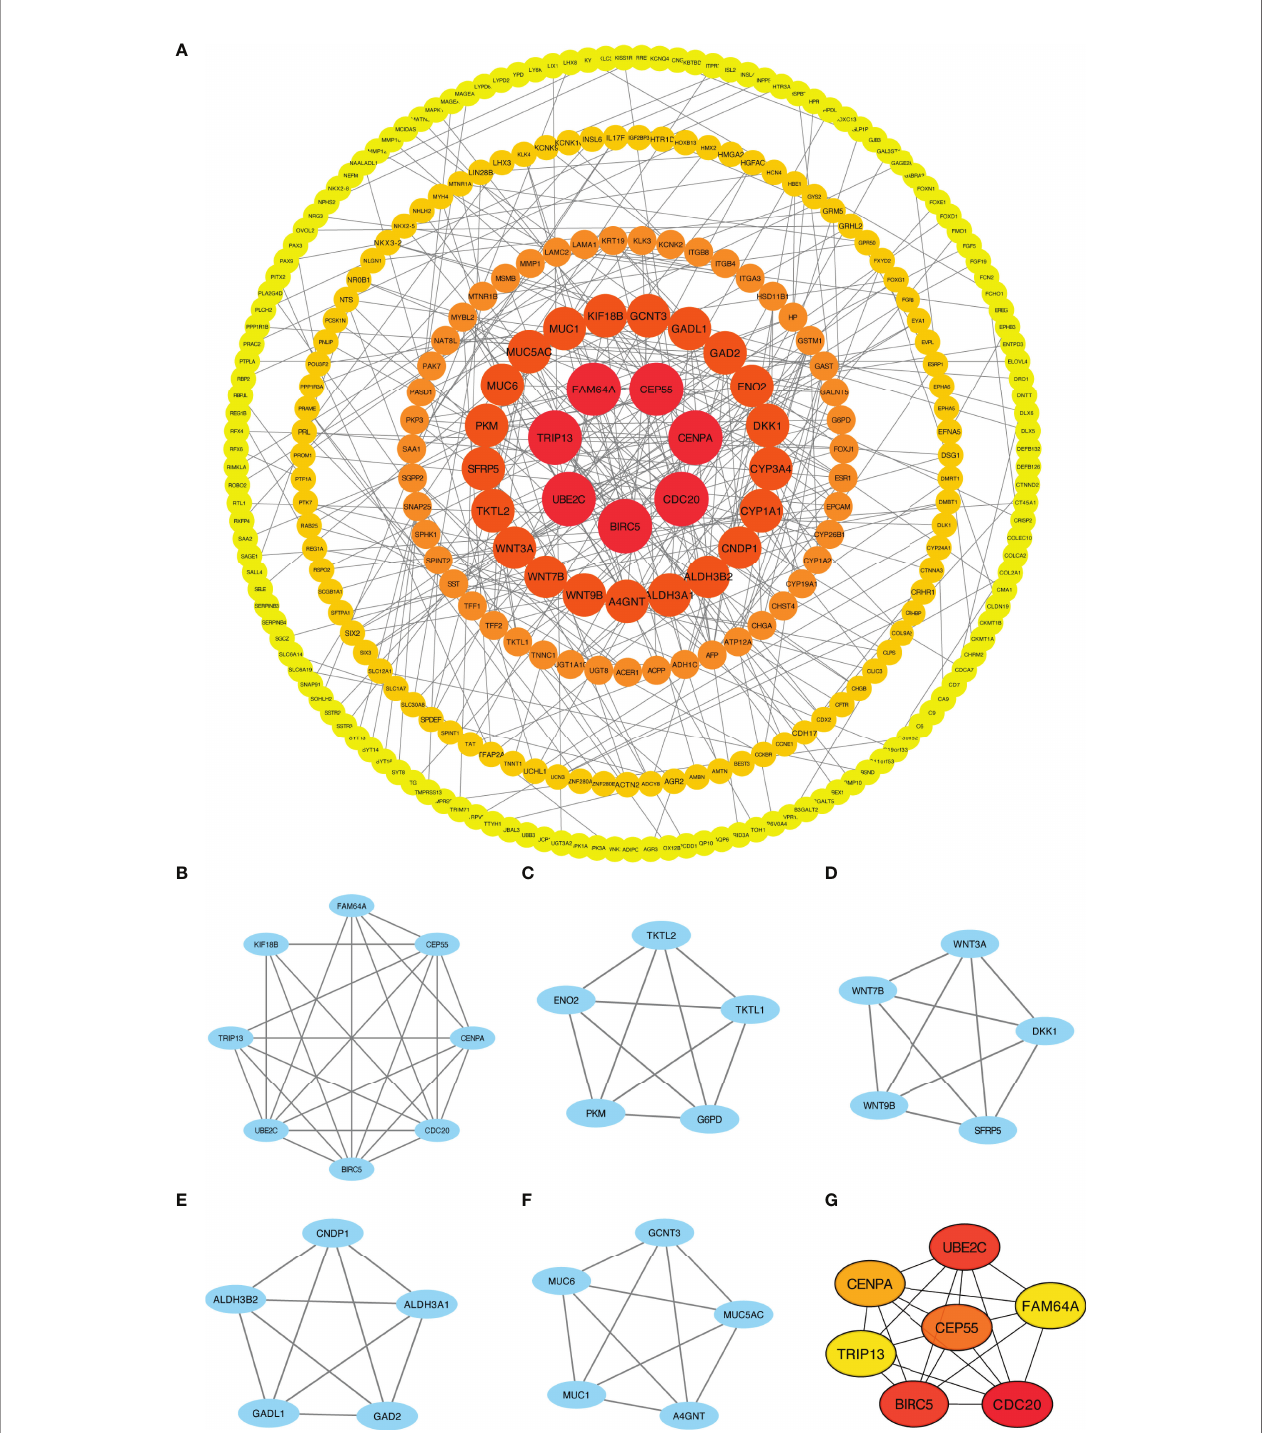
FIGURE 3 | PPI network enrichment analysis. (A) The PPI network was built based on PPI pairs identi fi ed by the STRING dataset. (B – F) Hub gene clusters were selected from the PPI network (criteria of total scores ≥ 5,000). (G) Top 7 hub genes in the PPI